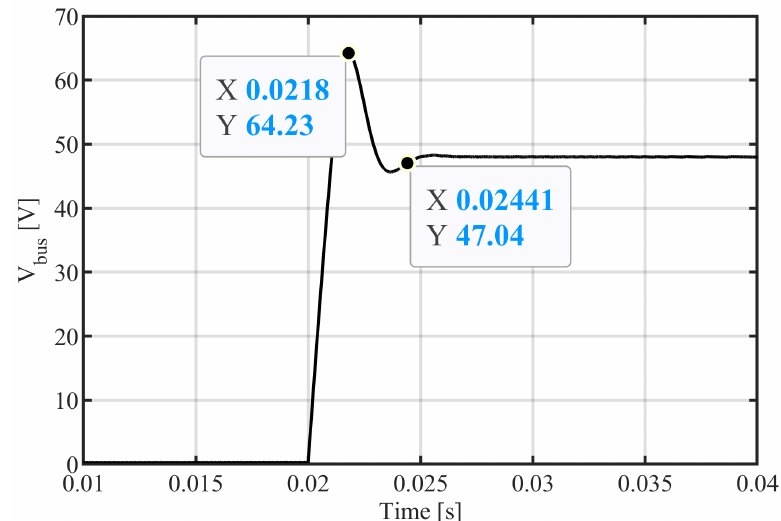
Figure 5. Simulation result with a bus voltage reference step change.